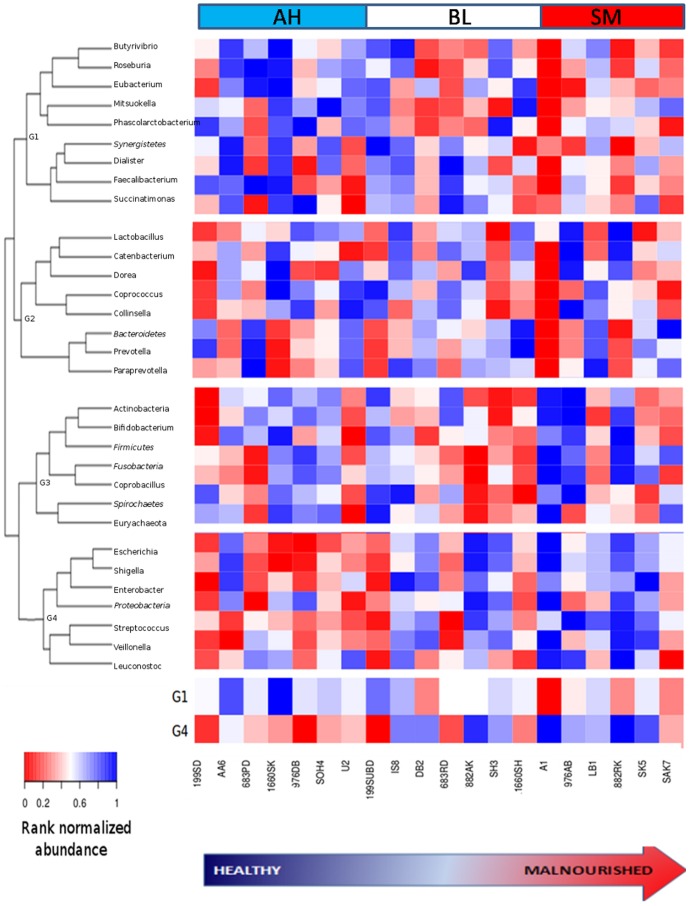
Variation of the rank normalized abundances of the 23 genera and 8 phyla (in italics) across the 20 gut metagenomes.The metagenomes are arranged in the bottom panel (from left to right) in decreasing order of their cumulative nutritional scores. The groups of microbiomes belonging to Apparently Healthy (AH), Borderline (BL) and Severely Malnourished (SM) children are also indicated. The taxa are arranged vertically on the left panel as a hierarchical tree based on the similarities in their abundance patterns. The four groups of taxa (G1–G4) with similar abundance patterns across the metagenomes are also demarcated. The cumulative rank normalized abundances of groups G1 (showing progressive increase with nutritional scores) and G4 (showing a progressive decrease with nutritional scores) across the 20 samples are provided in the bottom most panel.